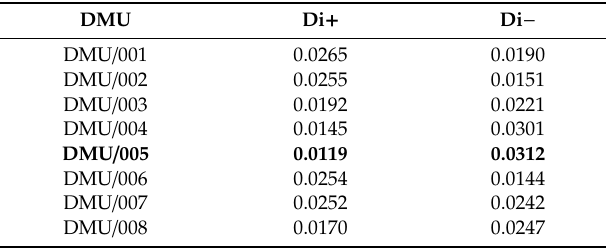
Figure 7. Final ranking list. Table 5. Negative ideal solution (NIS) and positive ideal solution (PIS) values in the Technique for Order Preference by Similarity to an Ideal Solution (TOPSIS)